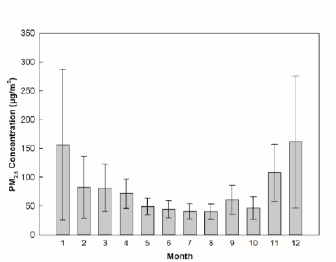
Figure2 The PM 2.5 Monthly Changes in Zhengzhou during 2016